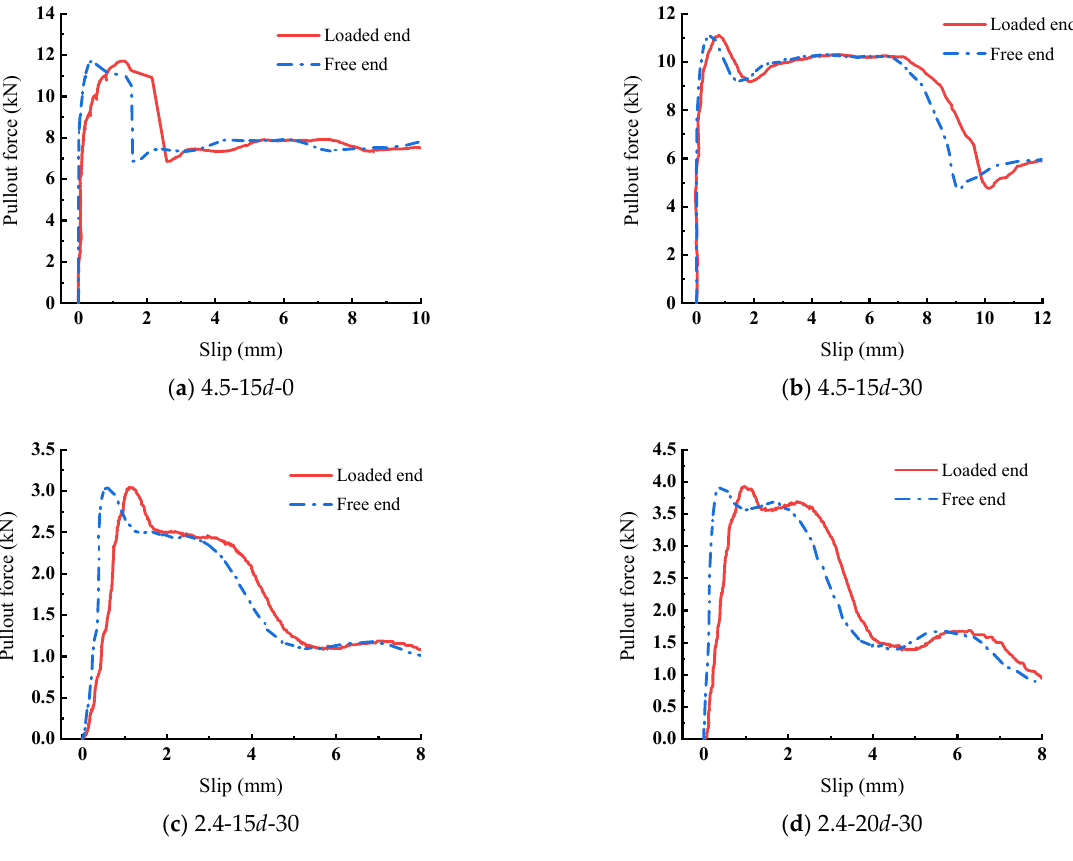
Figure 4. Representative pullout forces-slip curves.